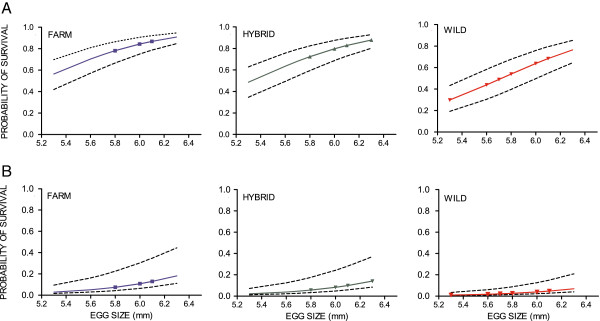
Probability of survival, experiment II. Predicted probability of survival in salmon of farmed, hybrid and wild origin against egg size in the A) restricted hatchery treatment and B) the restricted semi-natural treatment. Egg size in diameter (mm). Symbols illustrate the true egg sizes detected within each origin. Dotted lines illustrate uncertainty caused by the random effect of family and tank. Regression coefficients are given in Table 5.